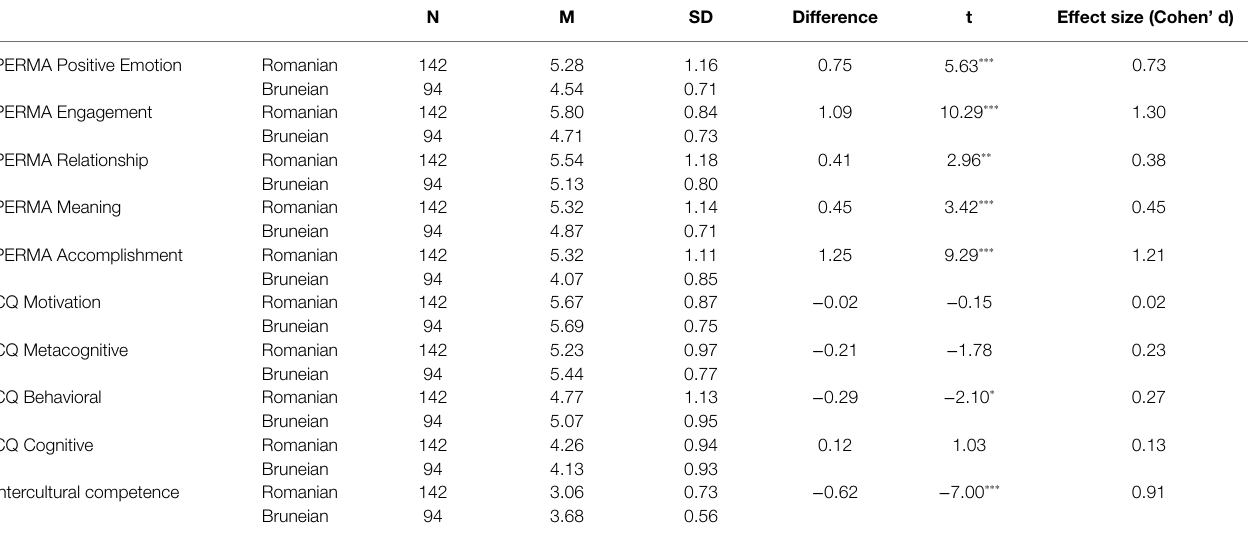
TABLE 4 | Nationality differences for PERMA wellbeing, cultural intelligence, and cultural competence